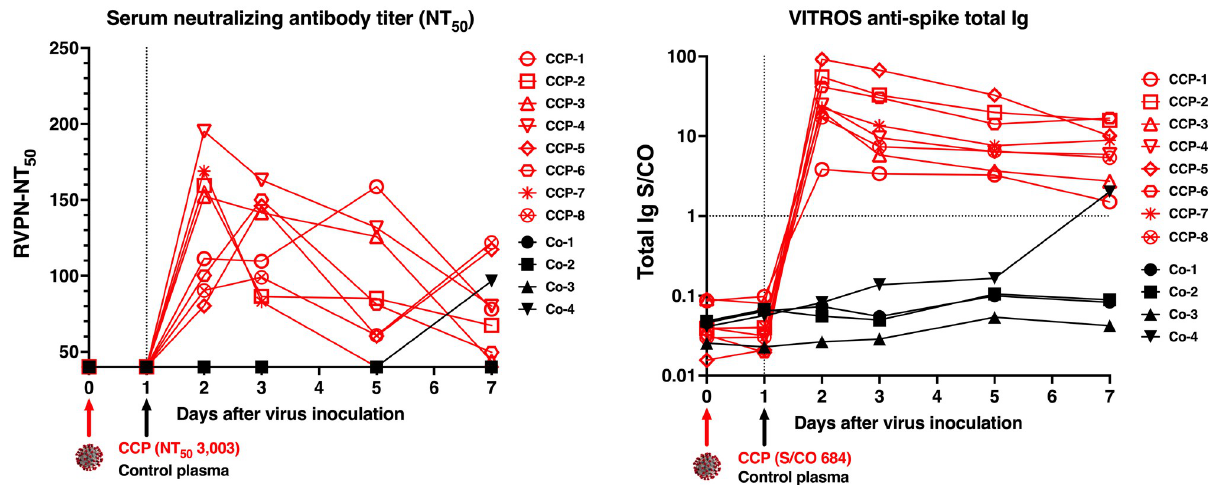
Fig 2. Neutralizing activity and anti-spike total Ig in serum of macaques after administration of convalescent or control plasma. Animals were inoculated on day 0 (red arrow) and administered either COVID convalescent plasma (CCP) or control (Co) plasma on day 1 (black arrow). (A) Neutralizing activity was measured in serum samples of the animals using a RVPN assay, with estimation of the titer to get 50% inhibition (NT 50 ). For comparison, the NT 50 titer of the administered CCP was 3,003. Samples with undetectable titers are presented at the limit of detection (1:40). (B) VITROS anti-spike total Ig is expressed as the ratio of signal over cut-off (S/CO). A value of � 1 indicates reactivity. The S/CO value of the administered pooled CCP was